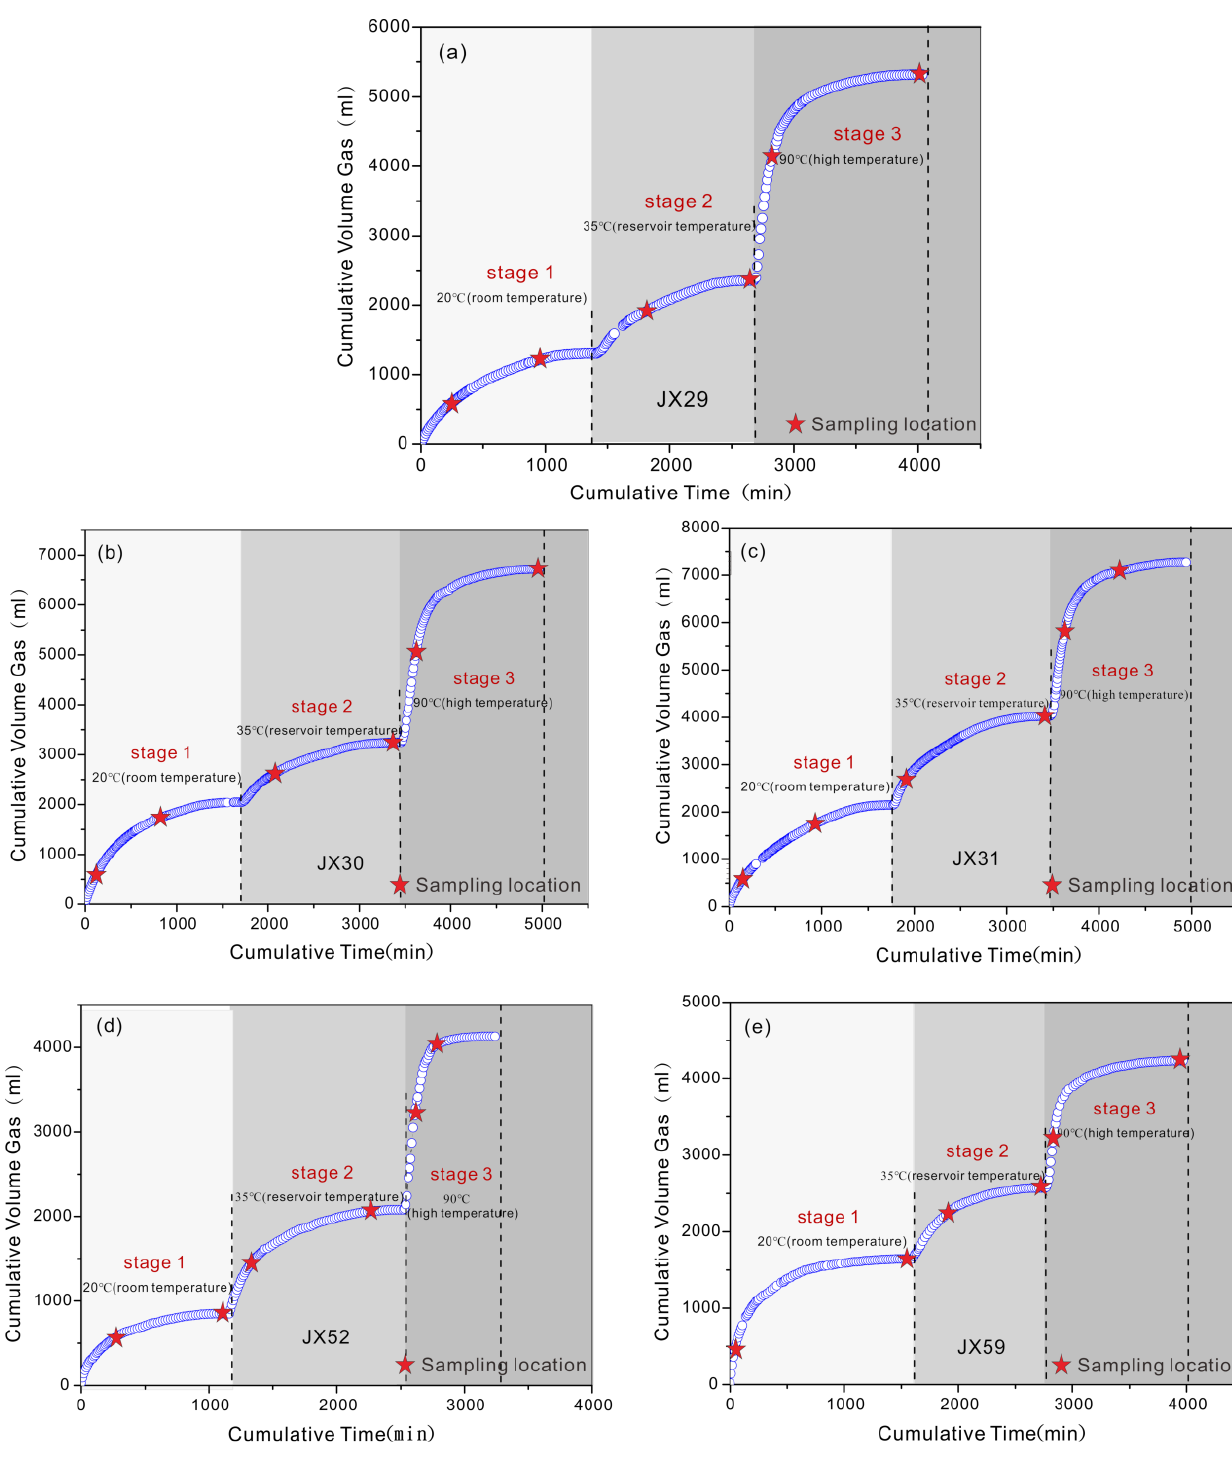
Figure 3. Desorbed gas volume curve versus time during three-stage degassing experiment. Stage 1: gases released at room temperature (20 °C); stage 2: gases released at reservoir temperature (35 °C); stage 3: gases released at high temperature (90 °C). ( a ) Desorbed gas volume curve versus time during three-stage degassing experiment of sample JX29. ( b ) Desorbed gas volume curve versus time during three-stage degassing experiment of sample JX30. ( c ) Desorbed gas volume curve versus time during three-stage degassing experiment of sample JX31. ( d ) Desorbed gas volume curve versus time during three-stage degassing experiment of sample JX52. ( e ) Desorbed gas volume curve versus time during three-stage degassing experiment of sample JX59.